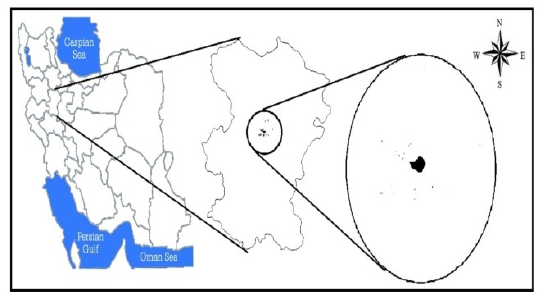
Fig. 1. Location of selected water wells and landfill in study